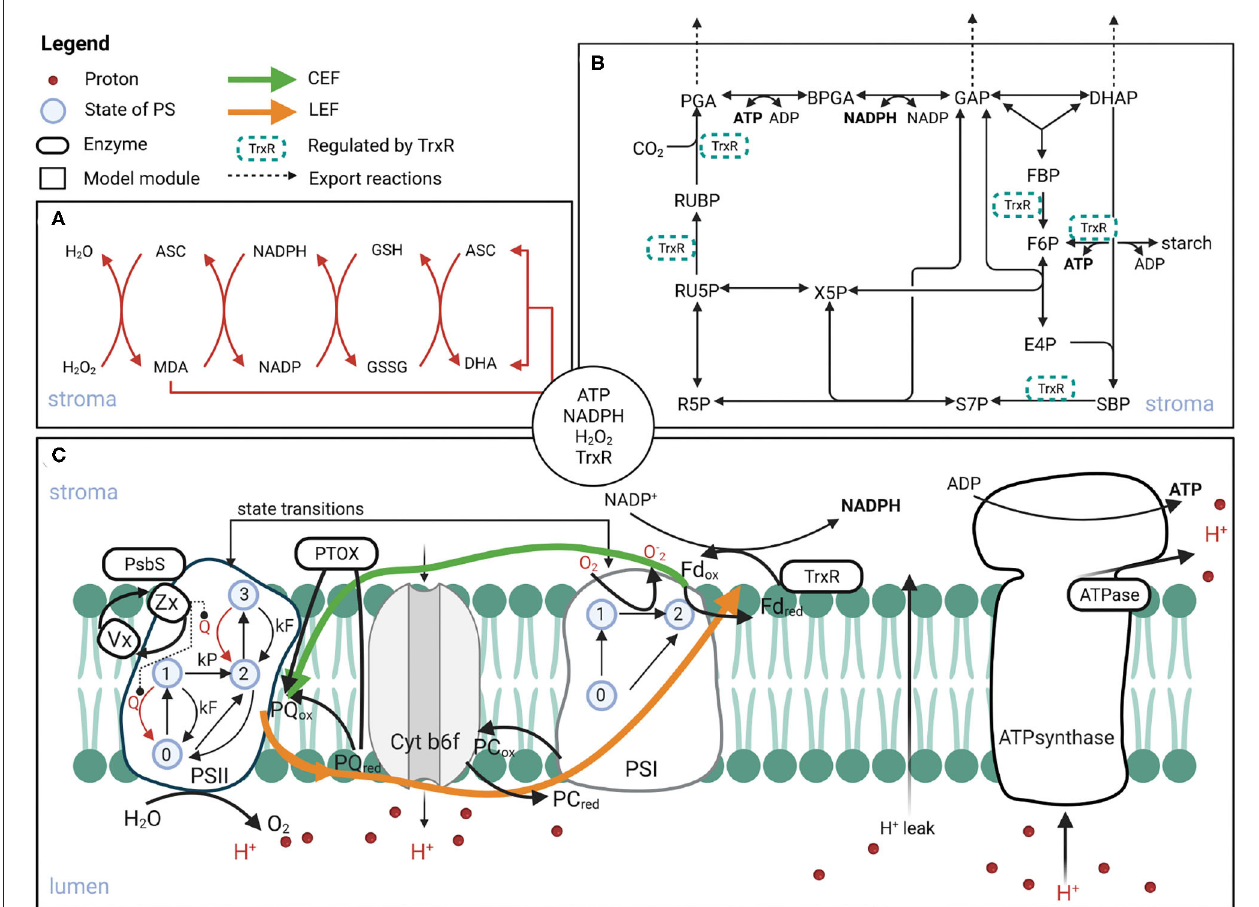
FIGURE 1 | Schematic representation of the processes included in the computational model of photosynthesis. The model consists of three modules: ascorbate-glutathione (ASC-GSH) cycle (A) , CBB with TrxR regulated reactions (B) , and PETC (C) . The compounds in the circle in the centre are the ones exchanged between the compartments. Created with